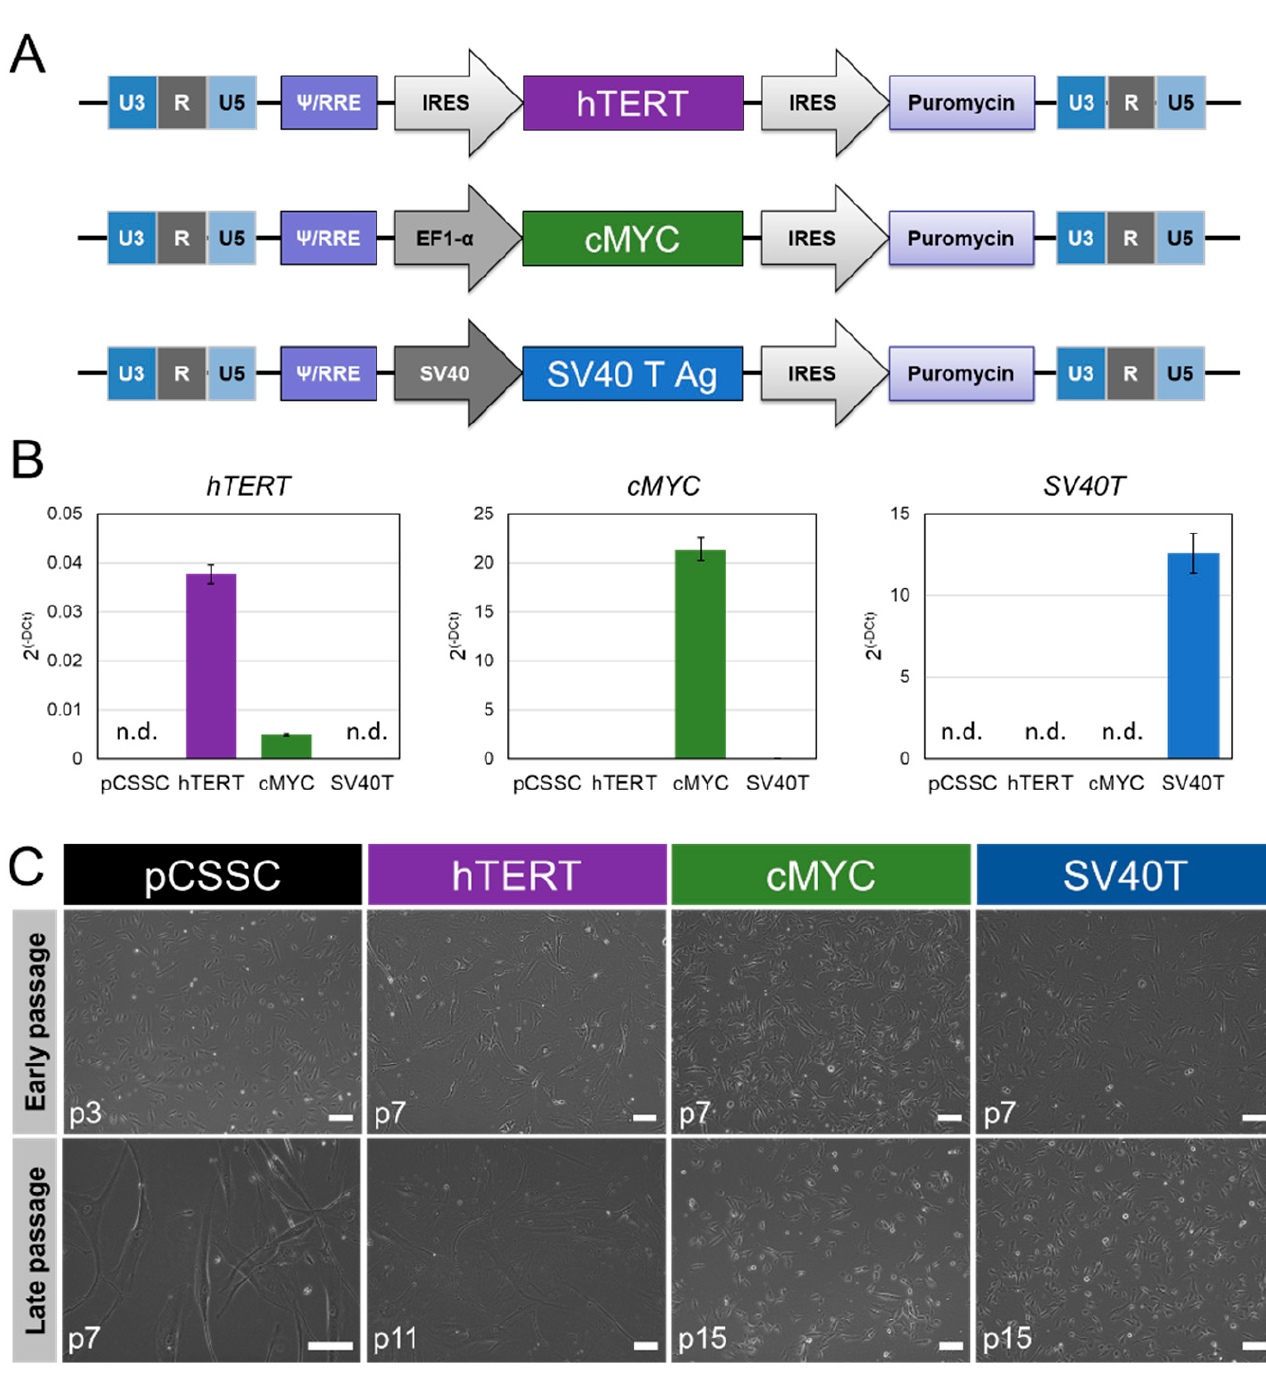
Figure 2. Cell proliferation of pCSSC and imCSSC cells. Immunostaining for the proliferation marker, Ki67, allowed quanti fi cation by computing the percentage of Ki67 positive cells against the number of nuclei (Hoechst staining). Passages 2–4 were used for pCSSC analysis at early passages; passage 7 was analyzed for pCSSC as late passages. Passages 10 to 14 were analyzed for the imCSSC.